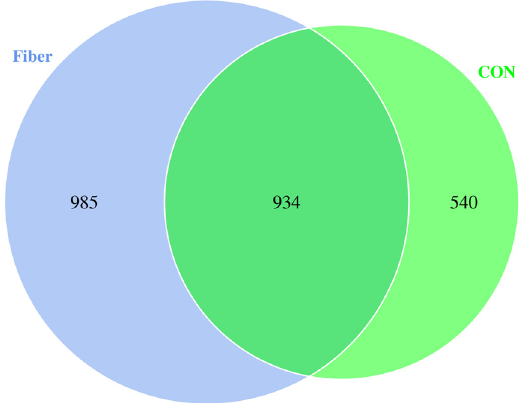
Figure 4. Venn diagram showing the unique and shared operational taxonomic units (OTUs) in the two groups ( n = 6 for each group).